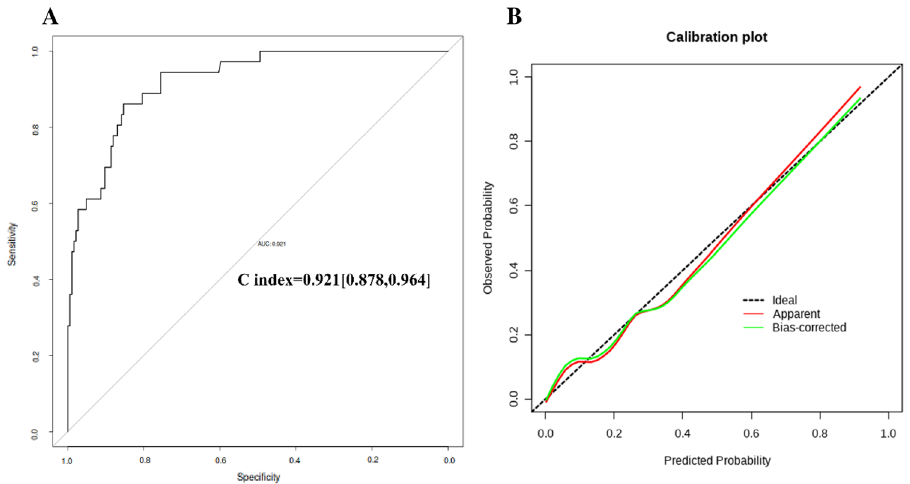
Figure 5. The C-index and calibration plots for validating the nomogram risk model. ( A ) The C-index value was 0.921(sensitivity and specificity were 0.878 and 0.964, respectively), which indicated a moderate accuracy for the nomogram risk model. ( B ) The calibration plots for the nomogram risk model present an excellent agreement between model prediction and observed